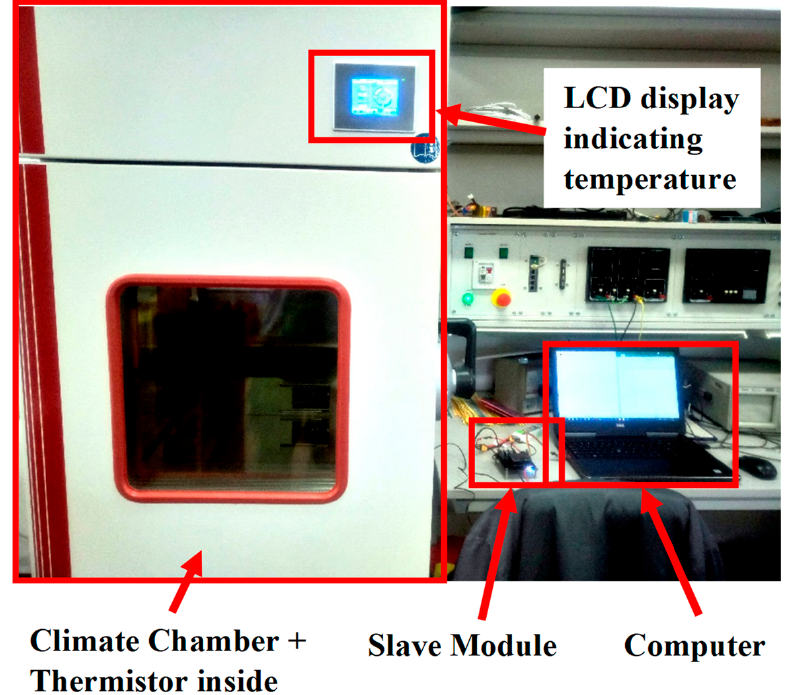
Figure 16. Experiment setup for measurement of temperature.